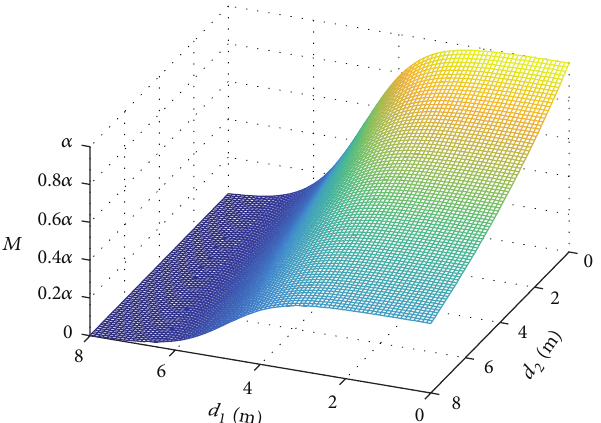
Figure 3: The curve of the subconscious strength 𝑀 for LP.